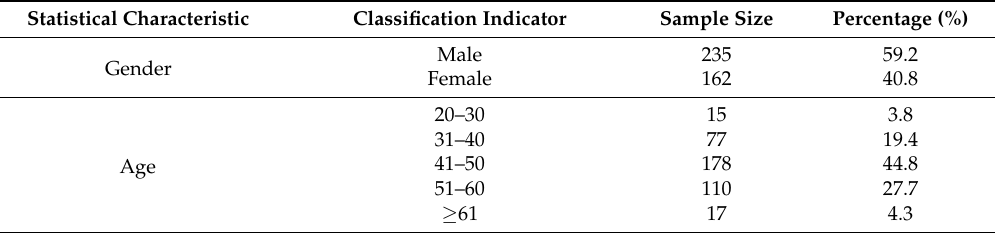
Table 1. Basic statistics of